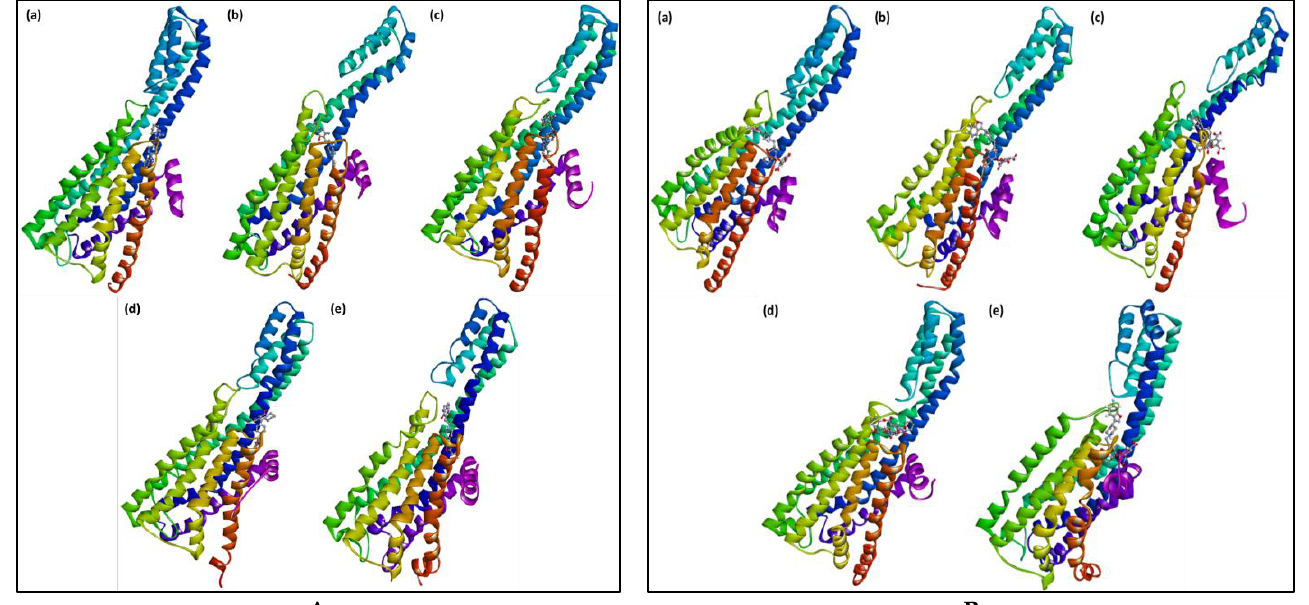
Figure 10. RisS structures ( A ) and CTcS structures ( B ) at ( a ) 1 ns, ( b ) 10 ns, ( c ) 20 ns, ( d ) 50 ns, and ( e ) 100 ns molecular dynamics runs, giving a visual representation of event sequence and process dynamics.